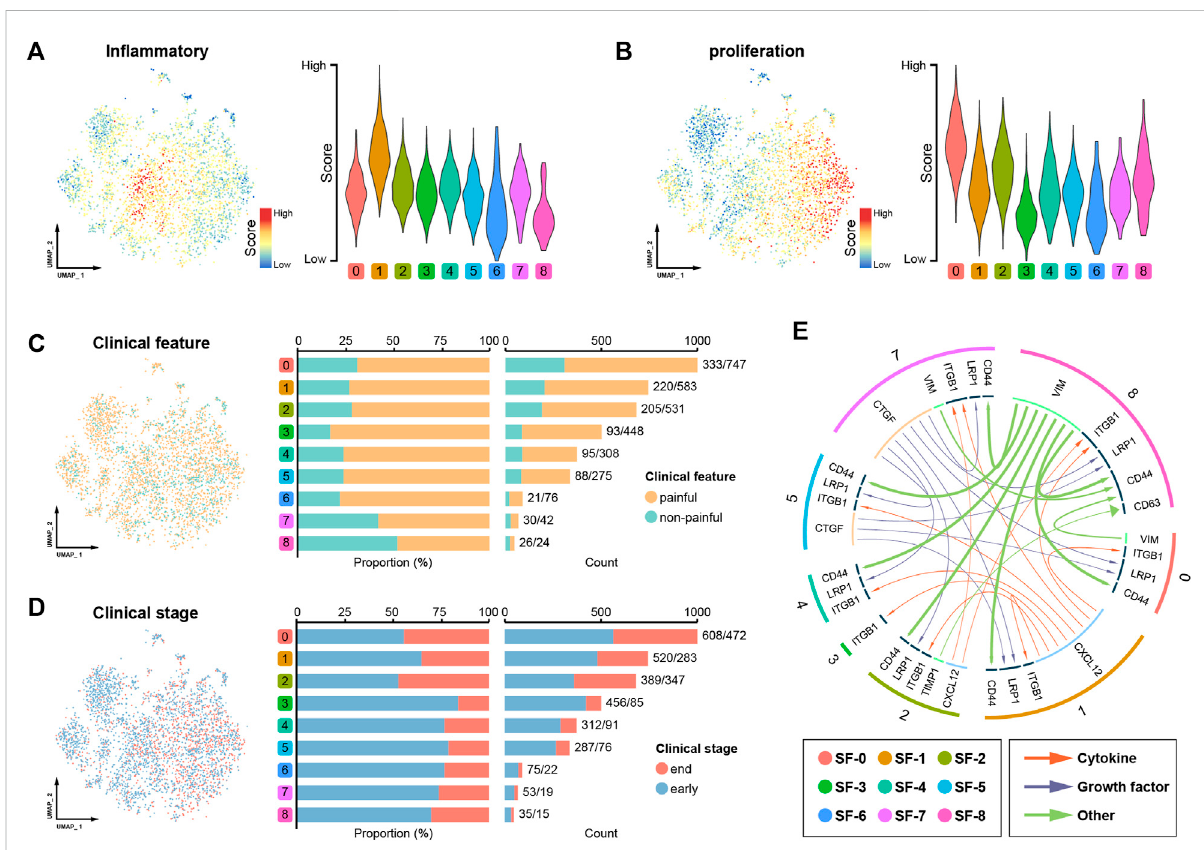
FIGURE 3 Assessment of the synovial microenvironment and intercellular communication. (A) UMAP plot showing the level of in fl ammation in the different cell clusters. (B) UMAP plot showing the proliferation ability of the different cell clusters. (C) Distribution of cells from patients with or without pain. (D) Distribution of cells from early- and end-stage OA patients. (E) Cell ‒ cell communication in the synovial